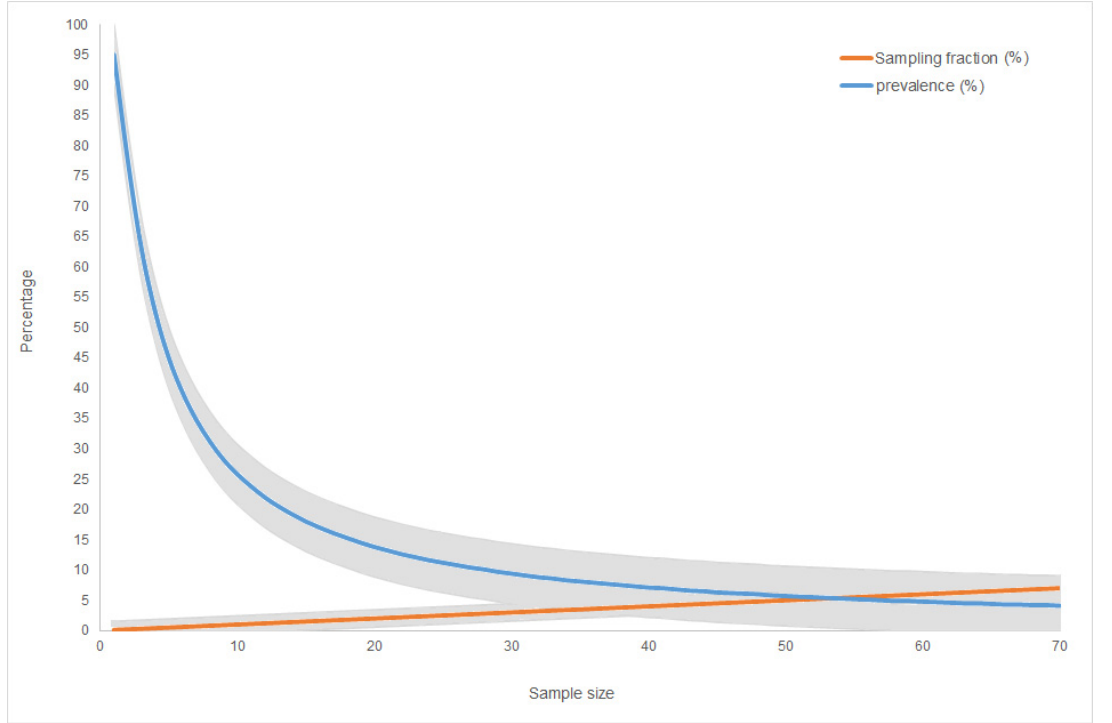
Figure 4. Graphical representation of the minimum ASF-negative carcasses (sample size) corre- sponding to the sampling fraction (%) of the overall population of the estimated carcasses and the disease prevalence (%) that could be excluded by the carcasses when assuming a maximum overall population of 2000 carcasses. The grey bands represent the 95% confidence limits.